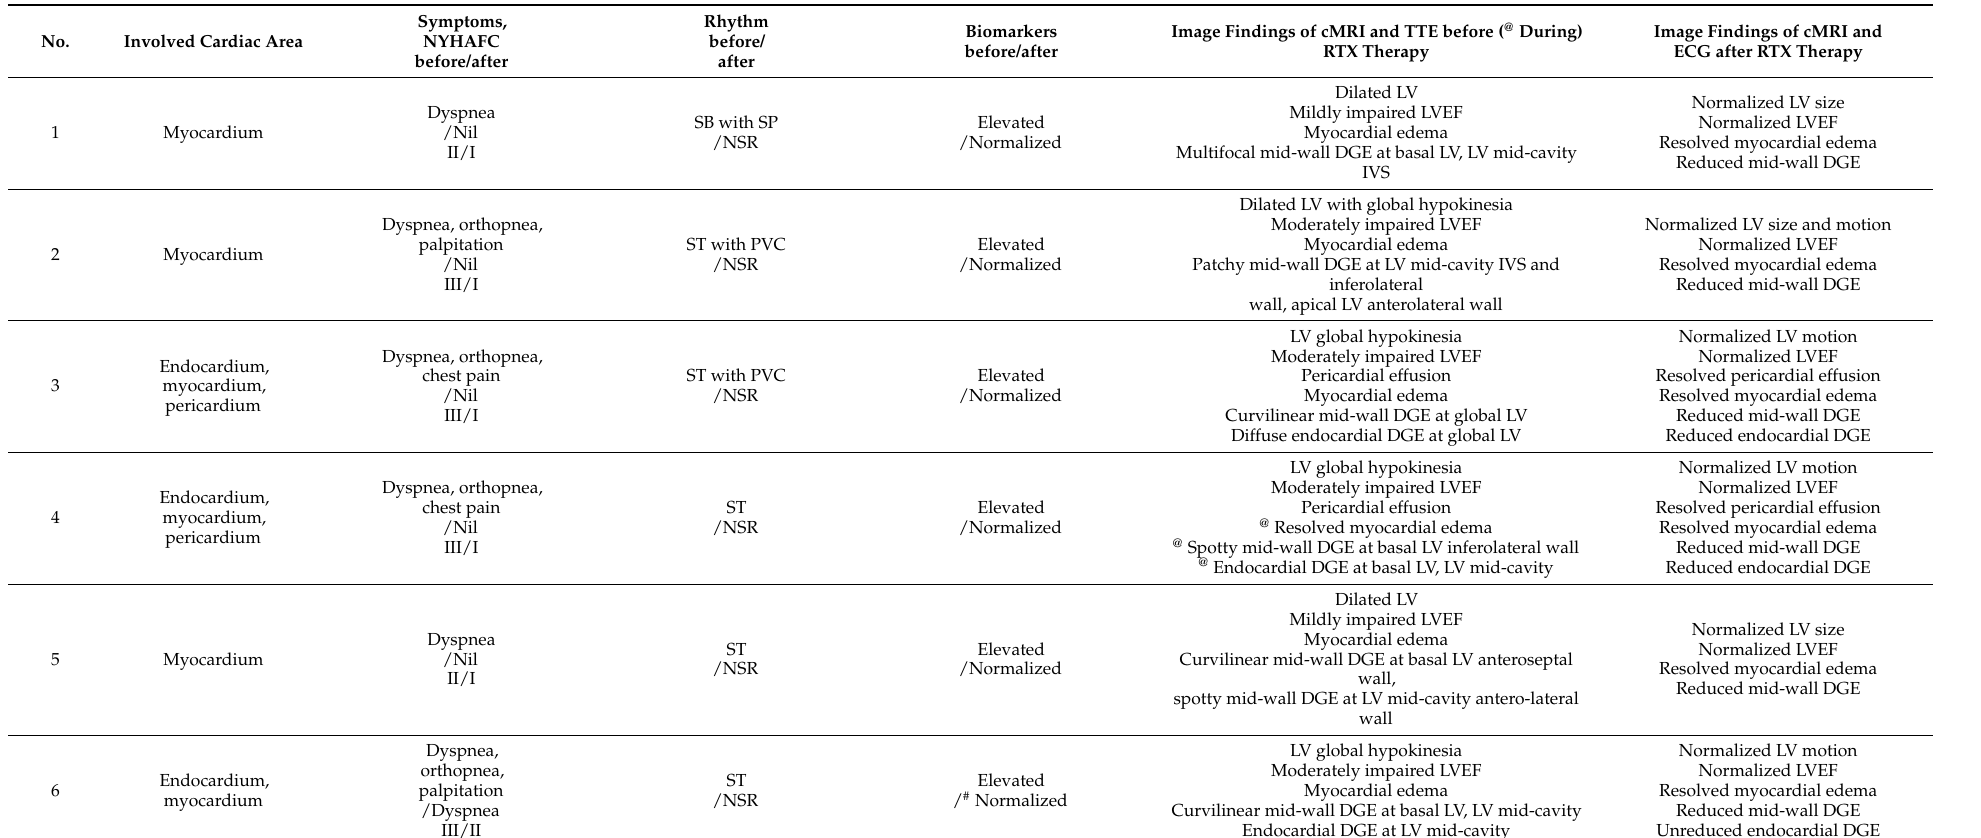
Table 4. Cardiac symptom, rhythm, biomarker and image data in six EGPA myocarditis patients receiving RTX